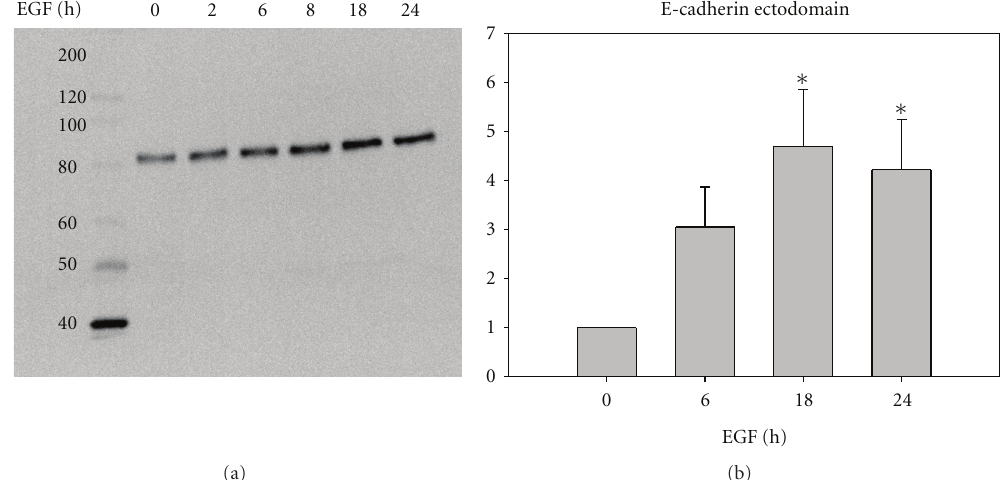
Figure 8: EGF receptor activation leads to accumulation of an E-cadherin extracellular fragment in conditioned medium. Subconfluent cells were serum-starved (without BSA in the medium) for 24 hours. Cells were treated with 20 nM EGF for the indicated times, then the conditioned medium was collected, concentrated, and resolved on an 8% SDS gel. Samples of conditioned media were normalized to the corresponding protein lysate, transferred onto PVDF, and probed with an antibody against the extracellular epitope of E-cadherin, which recognizes both full length (120 kD) and cleaved E-cadherin